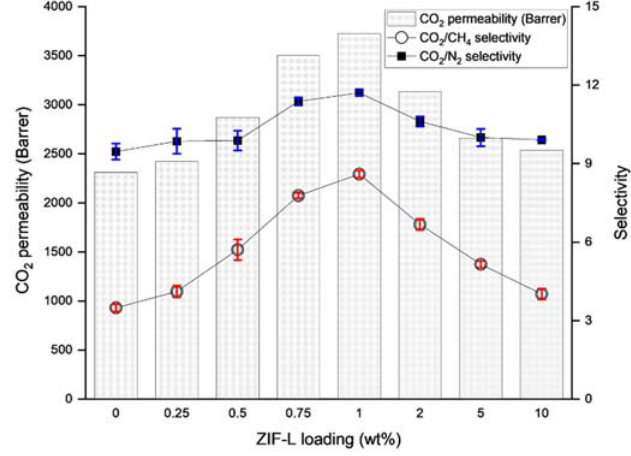
Figure 3. Separation performance of ZIF-L@PDMS membrane at various loadings of ZIF-L.